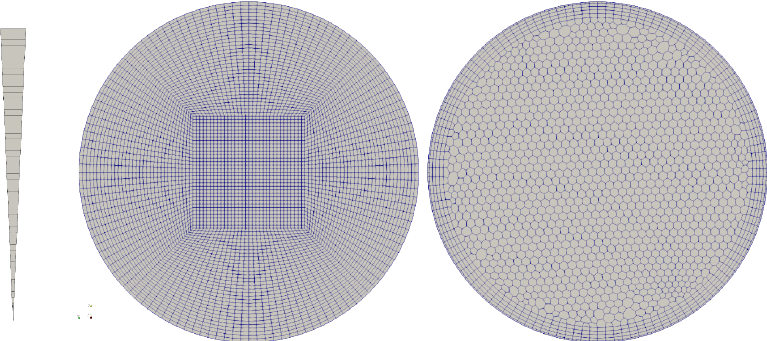
Figure 3. Mesh topology for the verification of the model: axisymmetric wedge, 50 cells radial; hexahedral, block-structured, 50 cells radial; polyhedral with boundary layer extrusion, 60 cells diameter.